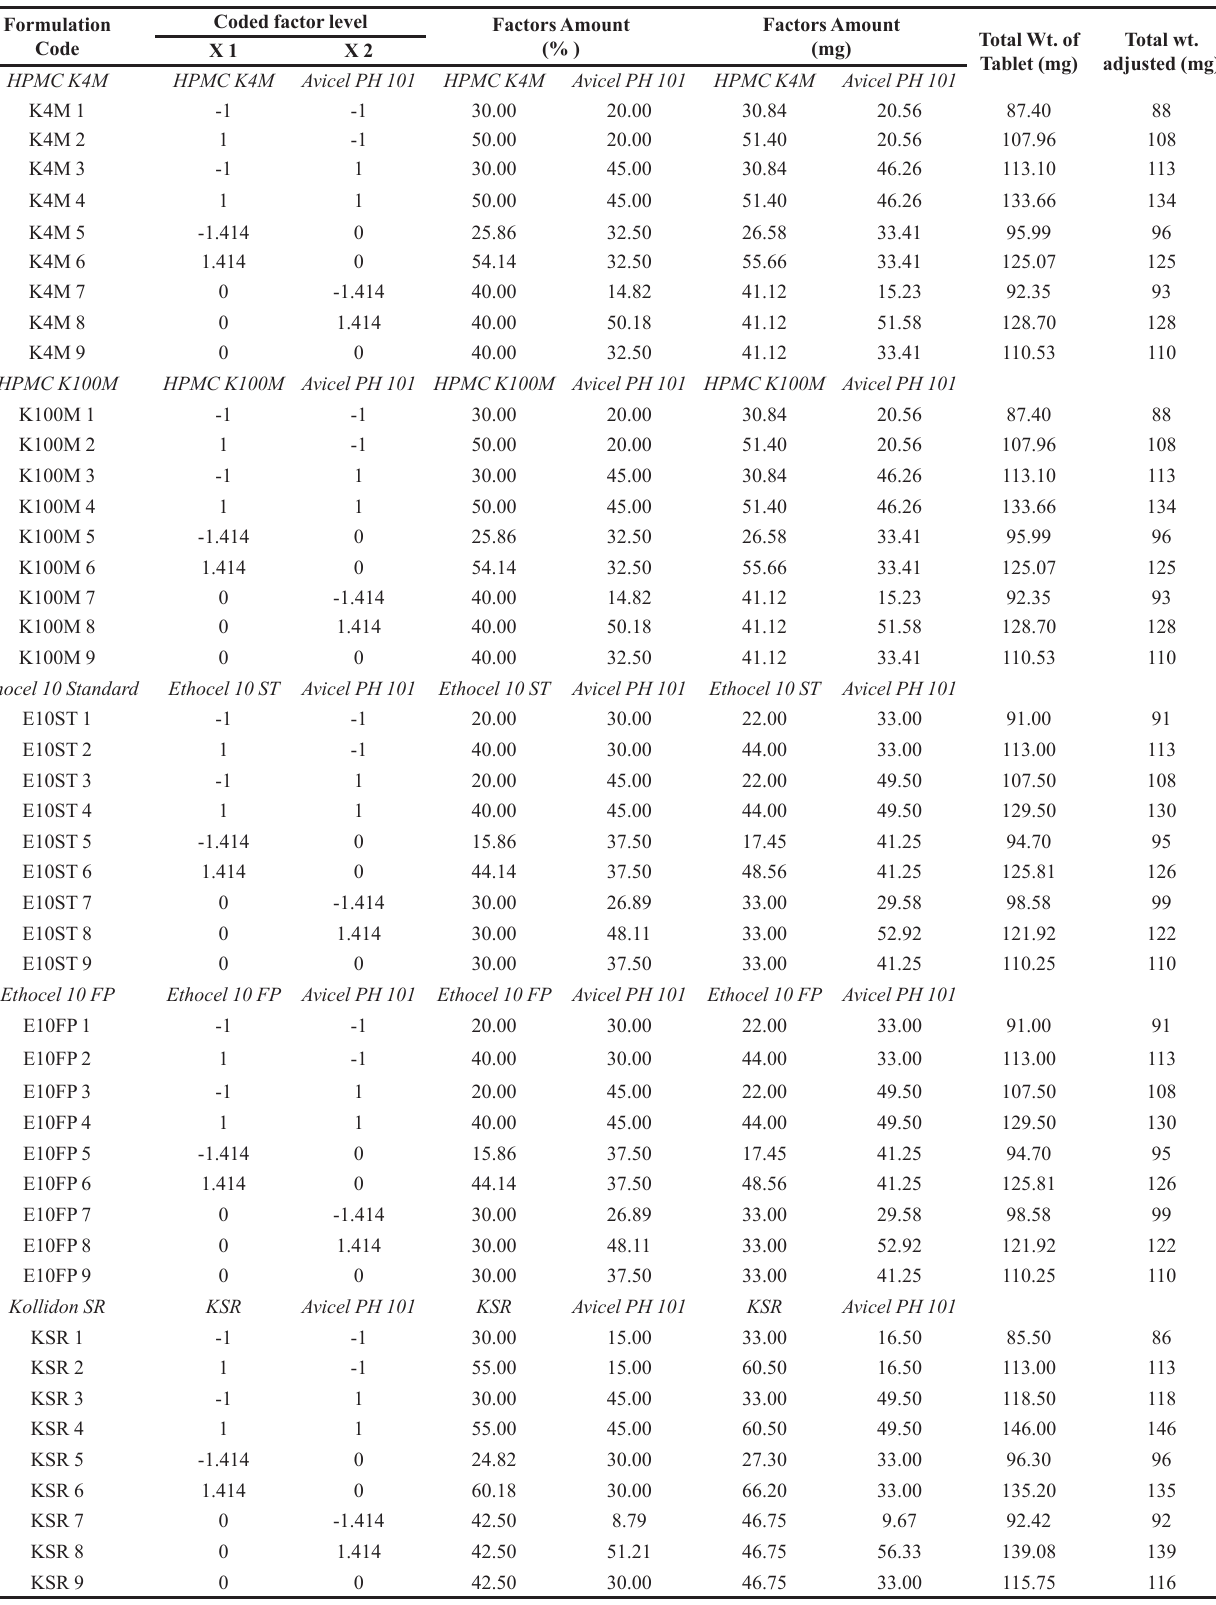
TABLE I - A two factor central composite rotatable design of experiments for tizanidine formulations Formulation